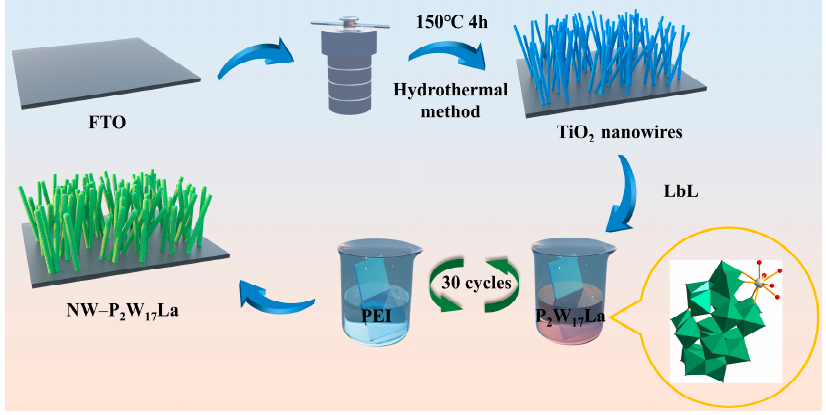
Figure 1. Fabrication process of the NW–P 2 W 17 La nanocomposite